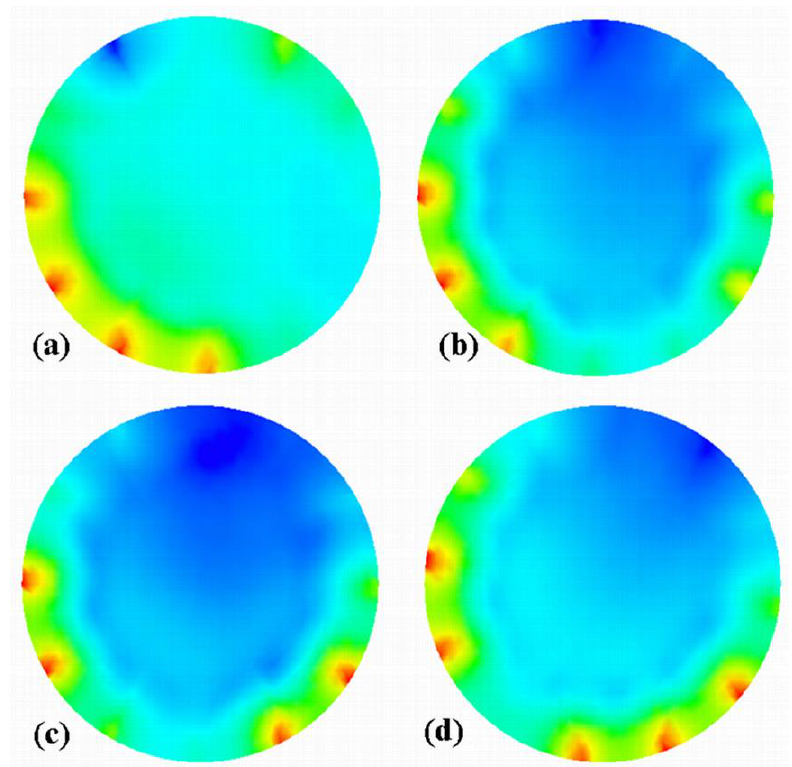
Figure 7. Four images ( a – d ) of the slug #4 reconstructed with LBP from capacitance data measured for individual successive positions of the motor (see that the image a corresponds to the one used for LBP/no rotation shown in Figure 5). This set was acquired clockwise.